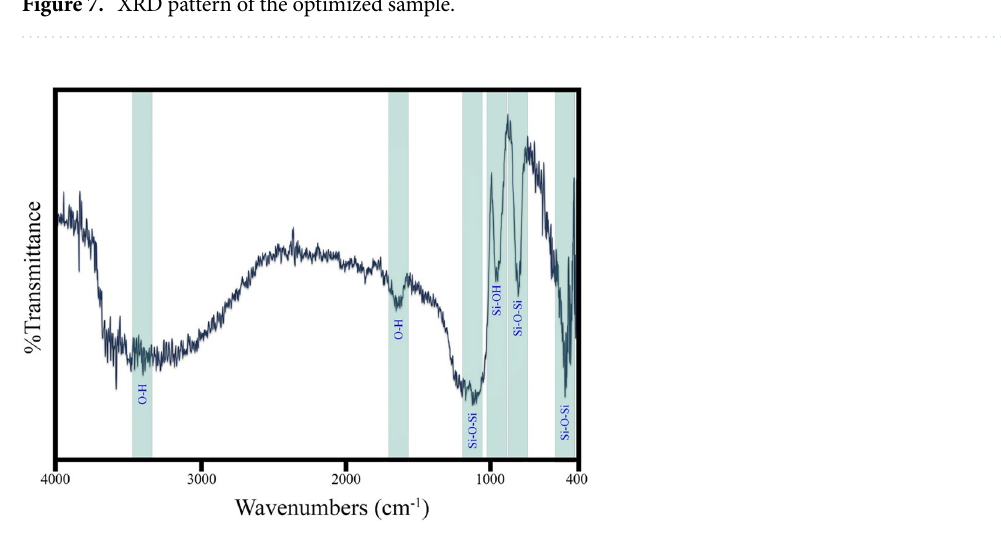
Figure 7. XRD pattern of the optimized sample.